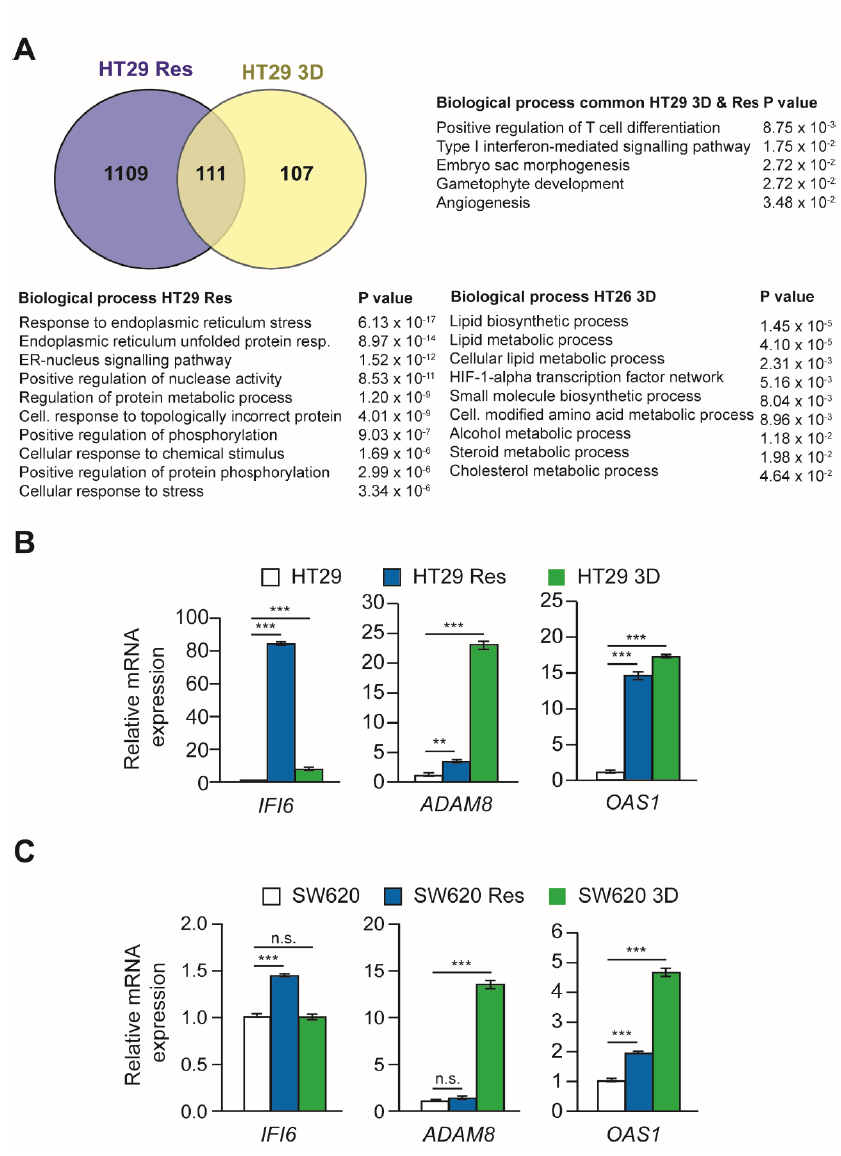
Figure 6. Comparative analyses of differential mRNA expression in HT29 oxaliplatin-resistant and 3D-cultured cells. Panel ( A ). mRNA was isolated from HT29 cells cultured under 2D conditions, oxaliplatin-resistant HT29 cells cultured under 2D conditions, and HT29 cells cultured under 3D conditions. Global mRNA expression levels were determined by RNA sequencing (RNAseq). Dif- ferentially expressed genes between HT29 oxaliplatin-sensitive and -resistant cells were identified (blue circle). Genes differentially expressed between HT29 cells cultured under 2D or 3D conditions were also determined (yellow circle). Finally, differentially regulated genes in these two conditions were compared and a Venn diagram of commonly regulated genes is represented. The main biological processes significantly over-represented in the genes differentially expressed in the three comparisons are shown. Panels ( B , C ). Comparison of the relative expression of three representative differentially expressed genes in cells cultured under 2D conditions, either sensitive or resistant (Res) to oxaliplatin, and cells cultured under 3D conditions (3D). Panel B represents the results obtained for HT29 cells, and panel C represents those obtained for SW620 cells. The mRNAs analyzed code for the proteins interferon-gamma inducible protein 6 (IFI6), ADAM Metallopeptidase Domain 8 (ADAM8), and 2 (cid:48) -5 (cid:48) -Oligoadenylate Synthetase 1 (OAS1). Experiments were repeated three times with similar results. Statistics: NS: non-significant differences; ** p < 0.01; *** p <